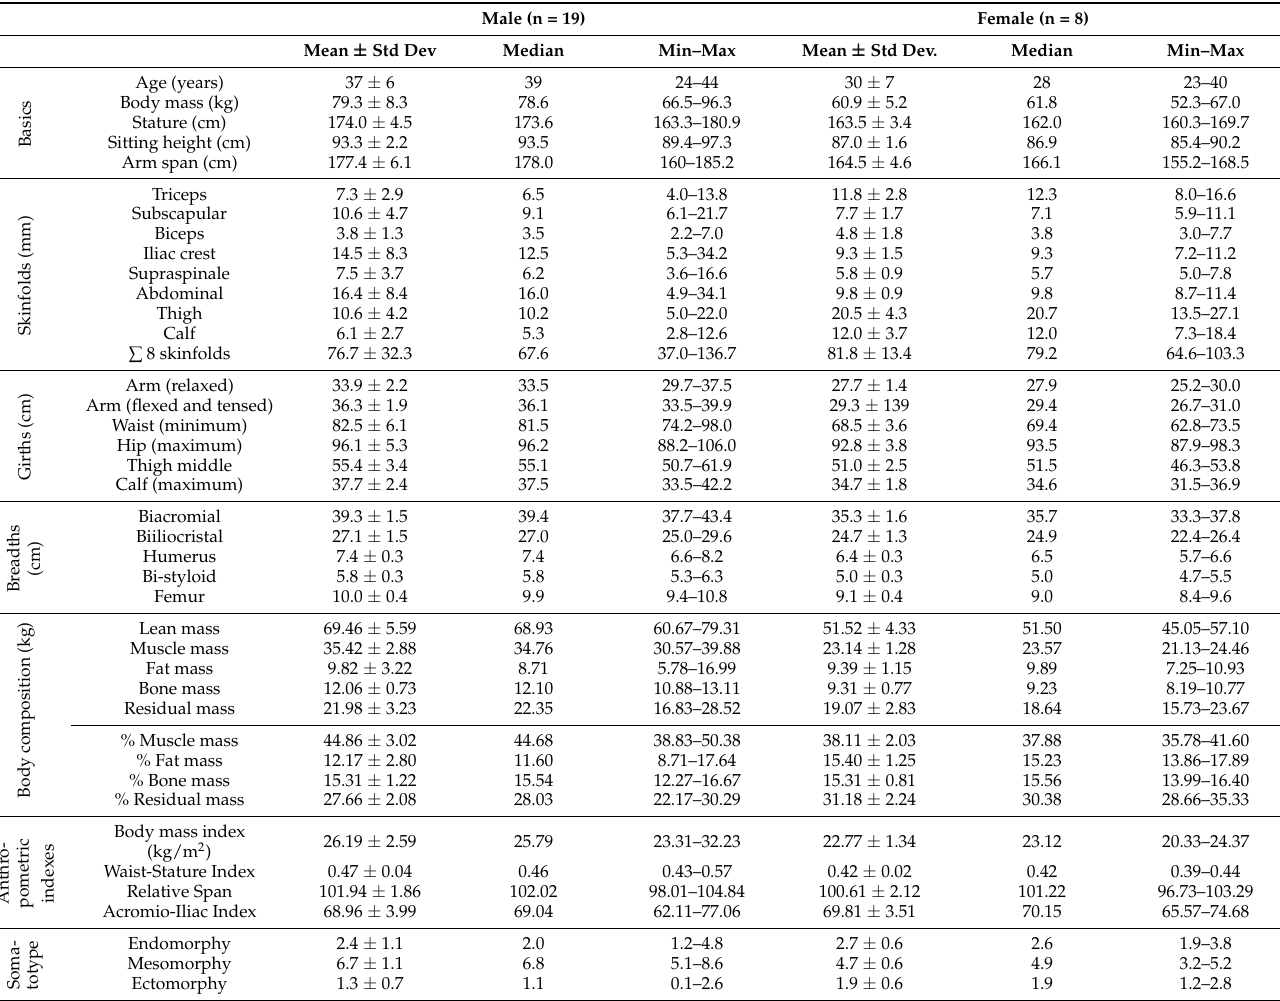
Table 3. Anthropometric values of the sample of CrossFit